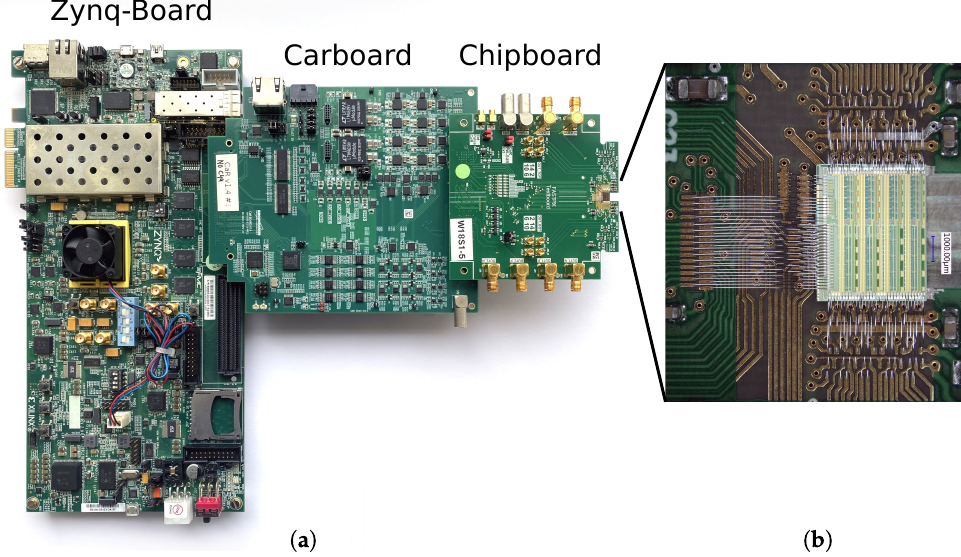
Figure 4. ( a ) Caribou system connected to FASTPIX chipboard. ( b ) FASTPIX chip on